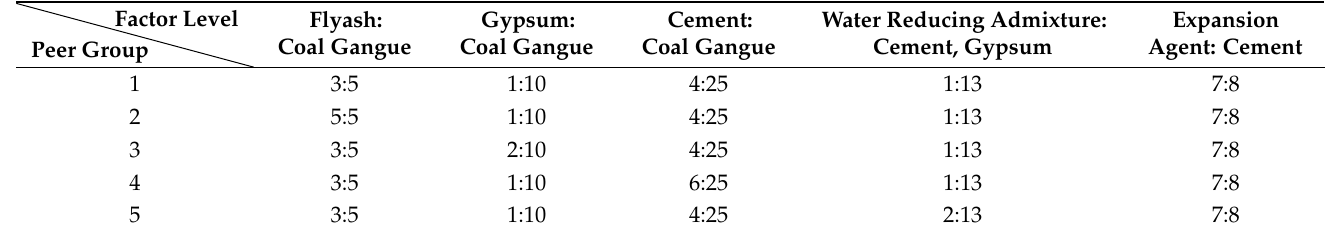
Table 5. Paste filling body experimental material ratio table. Table 5. Paste fi lling body experimental material ratio table.